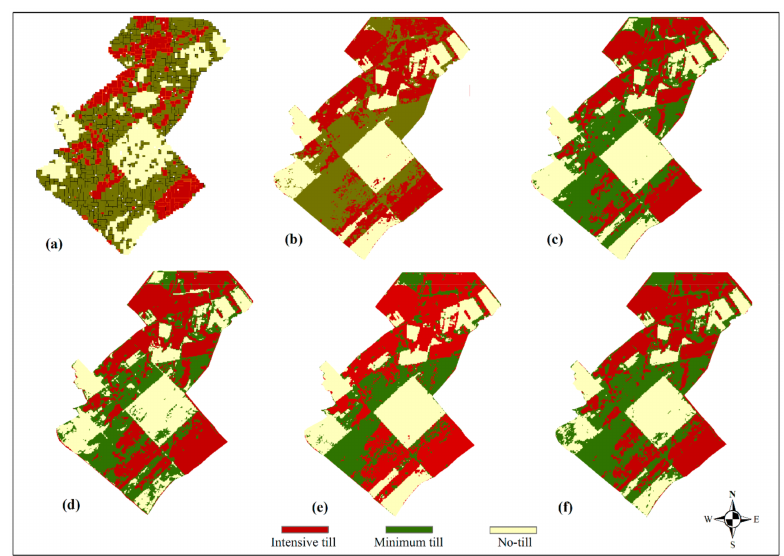
Figure 10. Classification maps of the tillage and planting practices for the Sentinel-2 multispectral image: ( a ) fuzzy OBIA, ( b ) ANN, ( c ) SVM (RBF), ( d ) SVM (polynomial), ( e ) SVM (linear) and ( f ) SVM